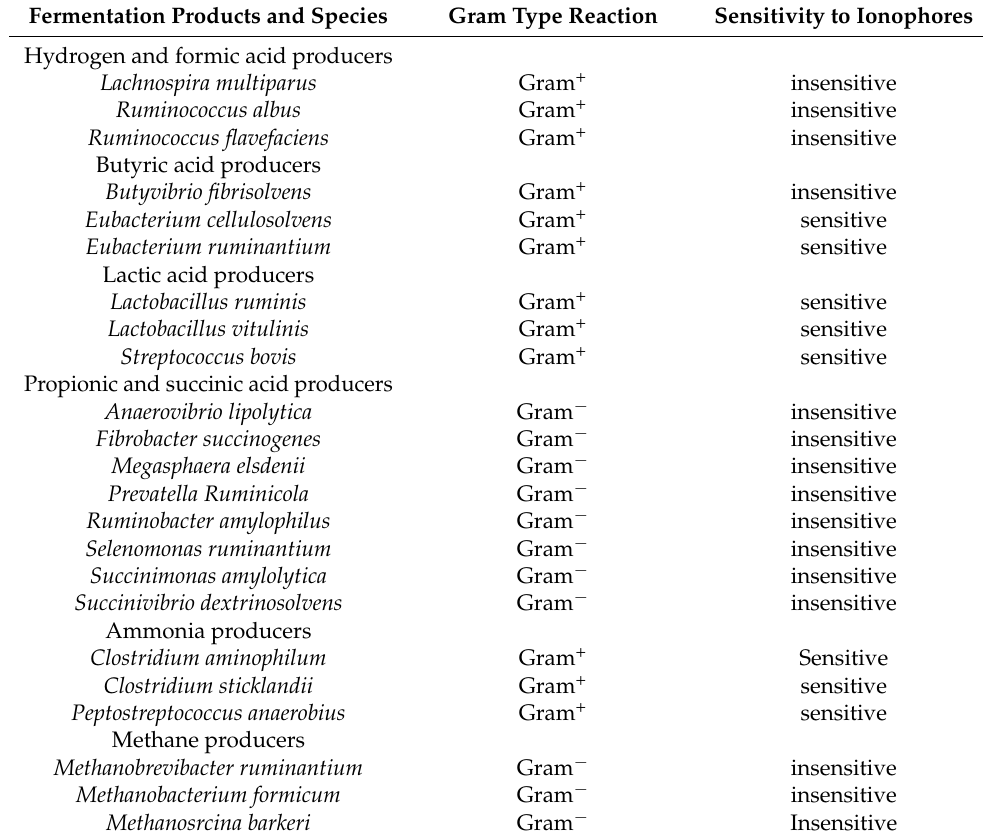
Table 2. Sensitivity response of ruminal bacteria to